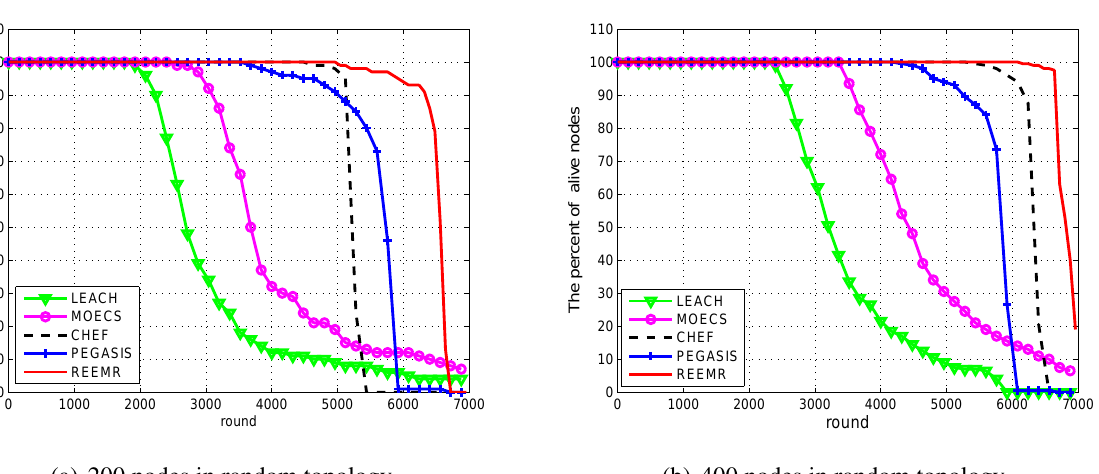
Figure 12. The network lifetime in rounds for random